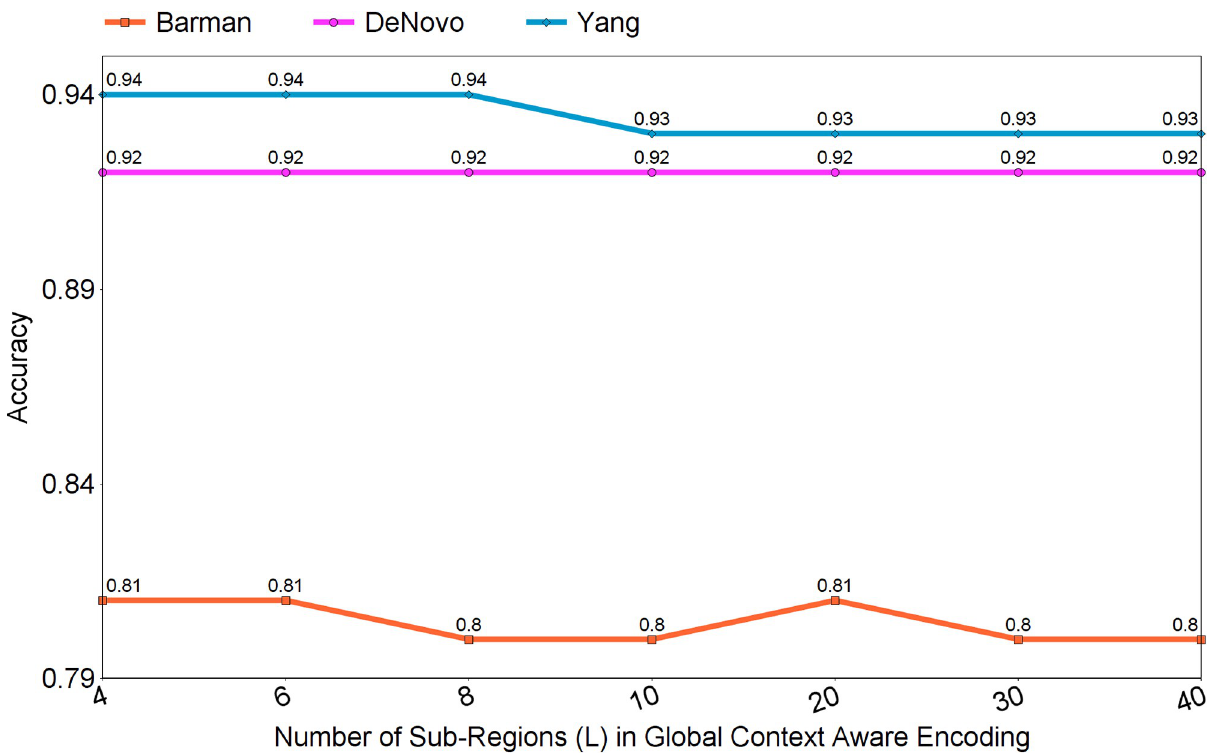
Fig 5. Impact of different size (L) sub-regions on the performance of global context aware encoding across three benchmark datasets namely Barman [28] and Denovo [12], and Yang et al dataset [14].